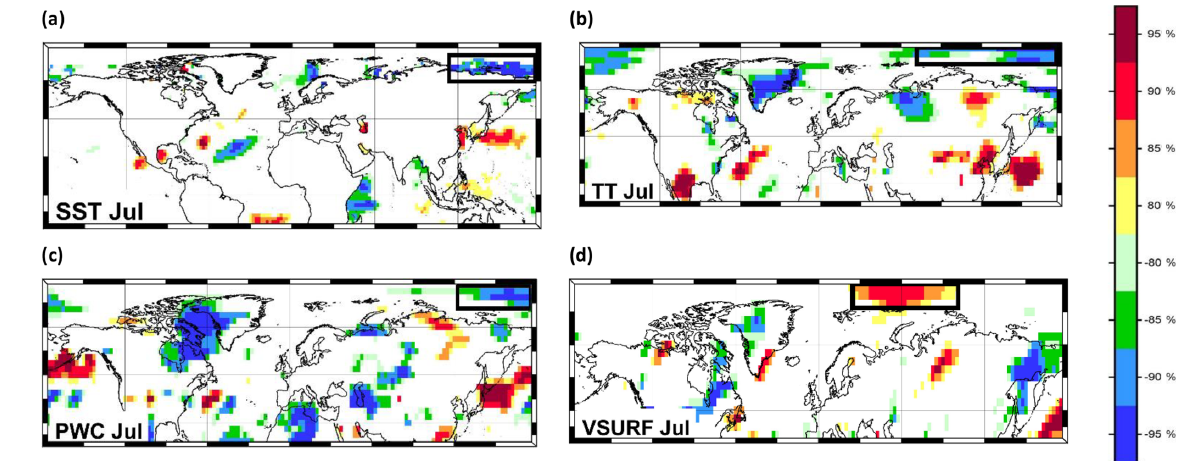
Figure 7. Stability map of the correlation between East Siberian September sea ice extent and (a) SST Jul, (b) TT Jul, (c) PWC Jul and (d) VSURF Jul. Regions where the correlation is stable, positive and significant for at least 80% of the 21-year windows are shaded with dark red (95%), red (90%), orange (85%) and yellow (80%). The corresponding regions where the correlation is stable, but negative, are shaded with dark blue (95%), blue (90%), green (85%) and light green (80%). The black boxes indicate the regions used for the September sea ice extent at the end of July in addition to the variables of May and June.